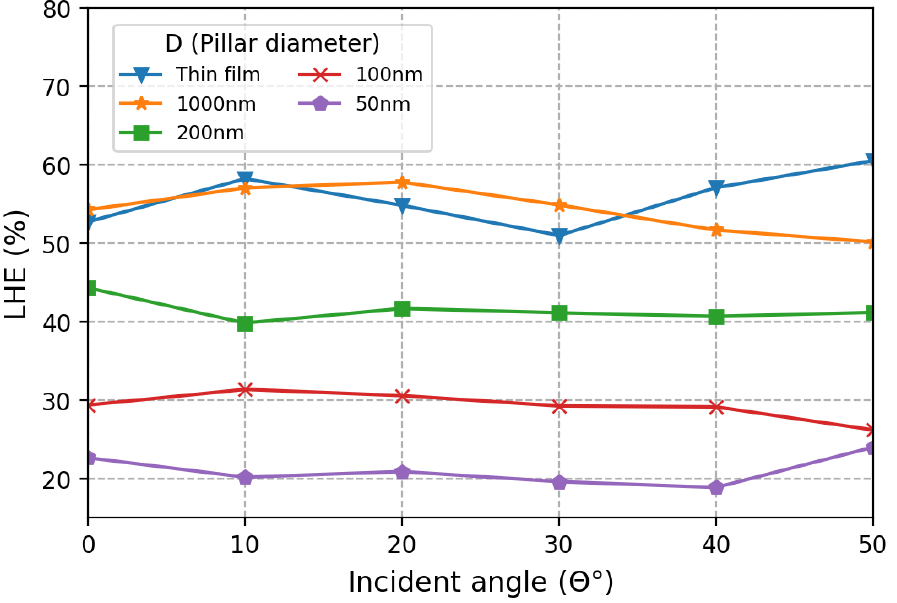
Figure 5. LHE as a function of the light’s incident angle θ . Photodetectors with small nanopillar diameters exhibit LHEs that are relatively insensitive to θ . Large-diameter photodetectors exhibit more angle dependence, which can be suppressed by the addition of a high-efficiency optical diffuser placed at the surface of the device. The absorption cut-off wavelengths are 485 nm, 518 nm, 536 nm, 570 nm, and 590 nm in the order of the nanopillar diameter.